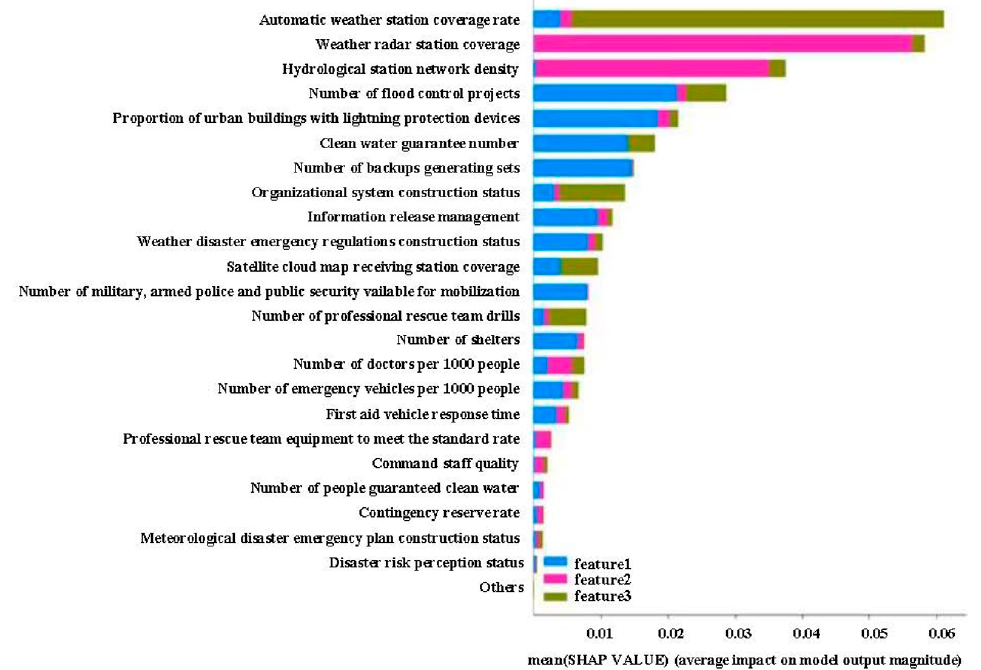
Figure 6. Visualization of the importance of original capability characteristics on capability sequence characteristics.